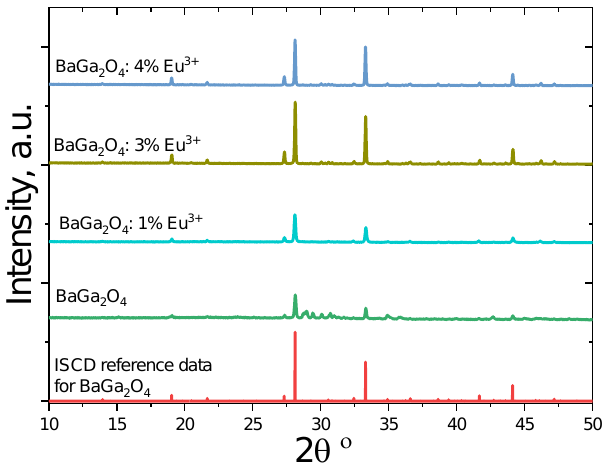
Figure 1. XRD patterns for undoped and Eu 3+ -doped BaGa 2 O 4 ceramics in comparison with ICSD reference data for BaGa 2 O 4 .